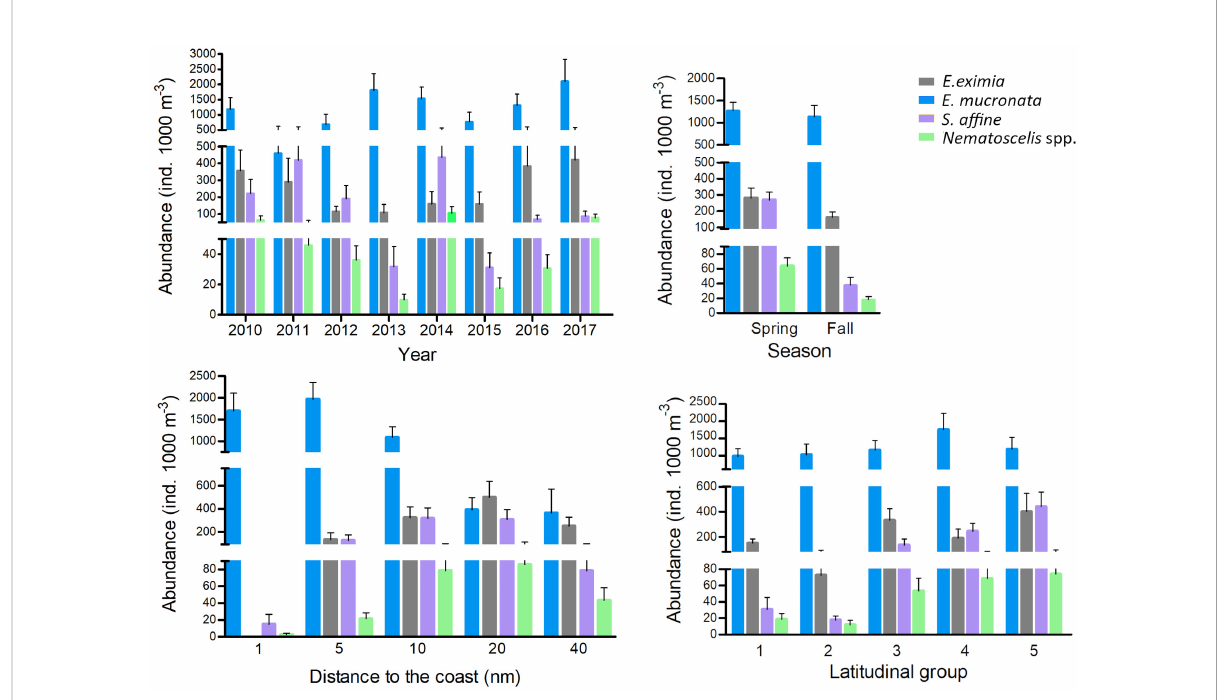
FIGURE 6 Interannual, seasonal, longitudinal (distance from the coast) and latitudinal (latitudinal groups as de fi ned in the Methods section) variability in mean abundances (ind. 1000 m -3 ) and standard error, of the 4 most abundant taxa.